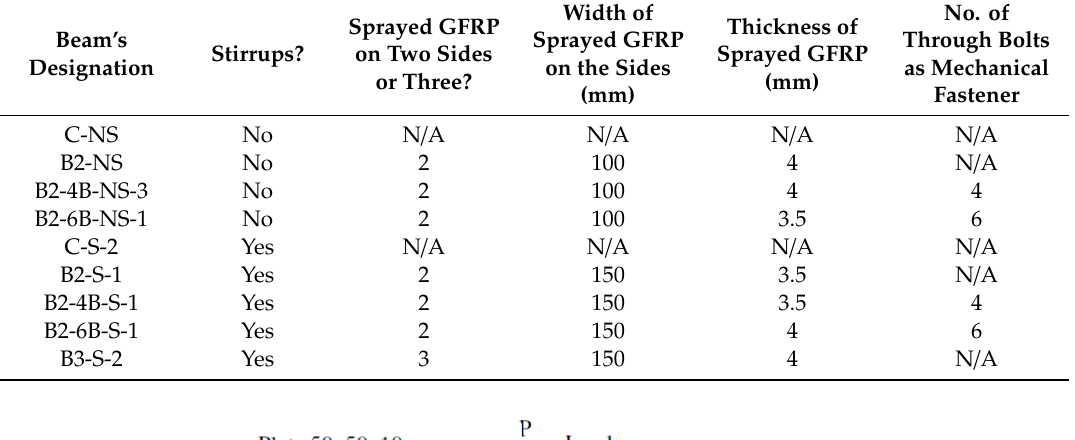
Table 4. Designations of RC beams tested under quasi-static loading as shown in Figures 1 and 2.